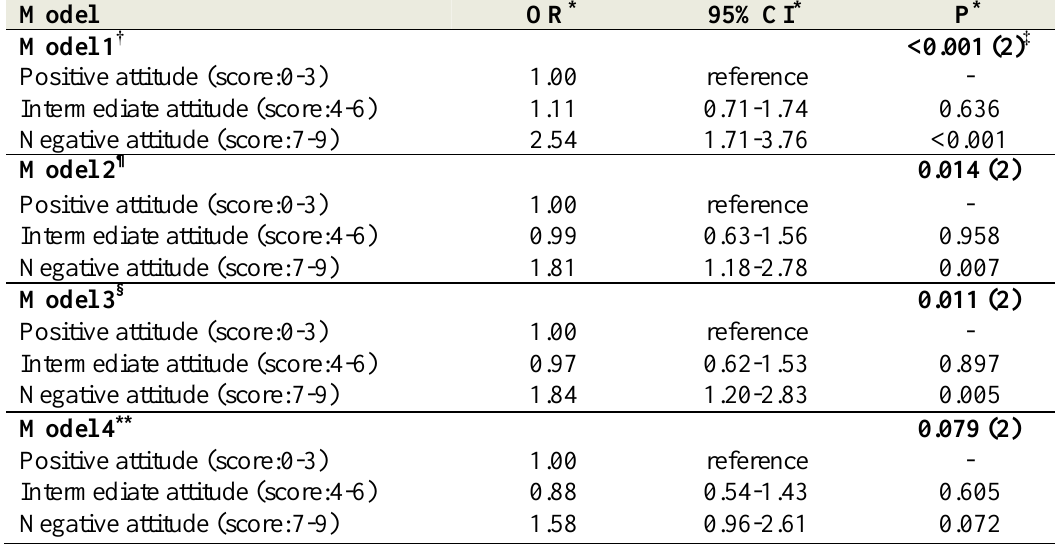
Table 3. Association of reaction to transition with self-perceived health status in a representative sample of primary health care users in Gjilan region,Kosovo